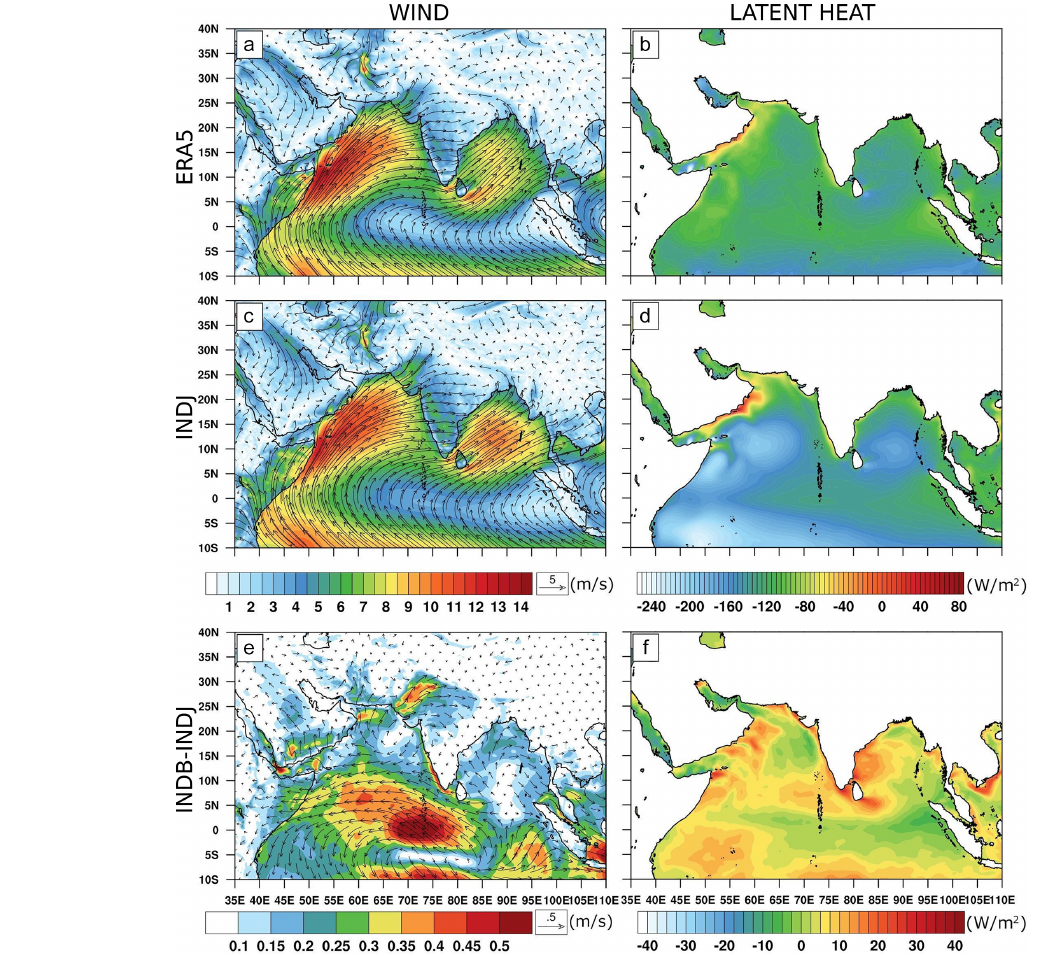
Figure 17. JJAS wind ( a , c and e , arrows are wind velocities, the color scale is the wind speed module) and latent heat ( b , d and f , the color scale is the latent heat flux) for ERA5 ( a , b ); INDJ experiment ( c , d ) and (INDB–INDJ) difference ( e , f